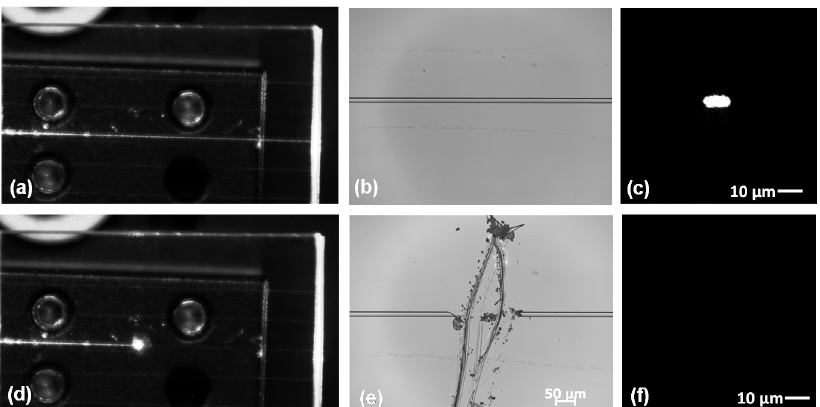
Figure 16. Damage detection with a TiO 2 –SiO 2 waveguide operating at 638 nm showing: ( a ) top-view of the unaffected guide before the impact, ( b ) corresponding microscope image and ( c ) guided mode. After the impact: ( d ) top-view, ( e ) microscope image and ( f ) absence mode observa- tion.